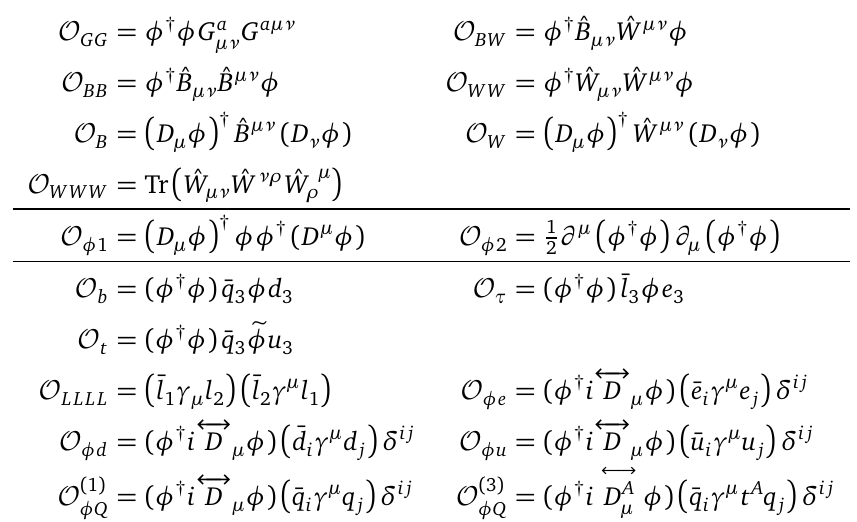
Table 1: Basis of dimension-6 SMEFT operators adopted in our global analysis. Flavor indices are denoted by i , j and are implicitly contracted when